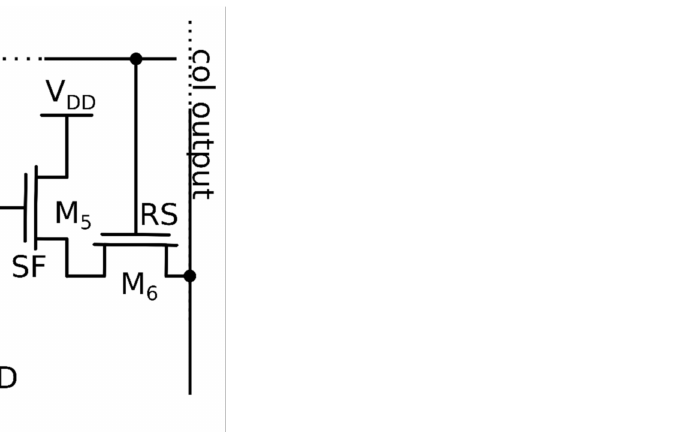
Figure 3. Proposed double-mirrored, low, dark current pixel design. In the proposed pixel design, 3 transistors are added compared to the logarithmic pixel with the purpose of enforcing a zero-voltage potential across the photodiode